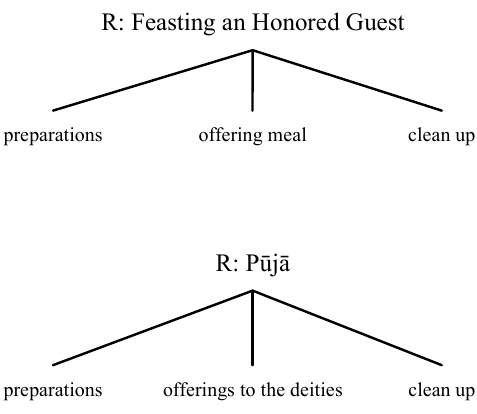
Figure 5. Metaphoric Extension to Ritual.